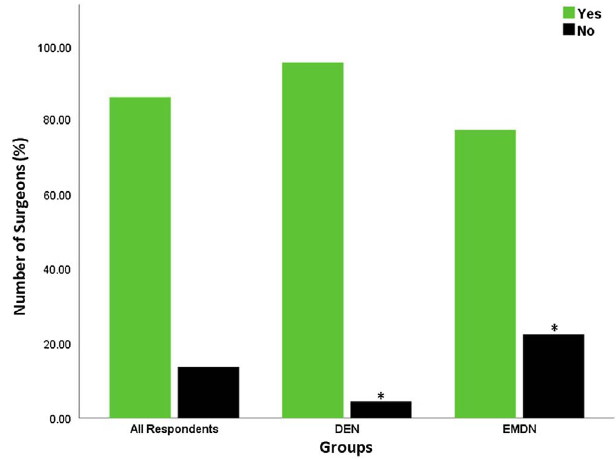
Figure 5. Access to physiotherapy plans as reported by the participating surgeons. Signi fi cant differences are denoted by